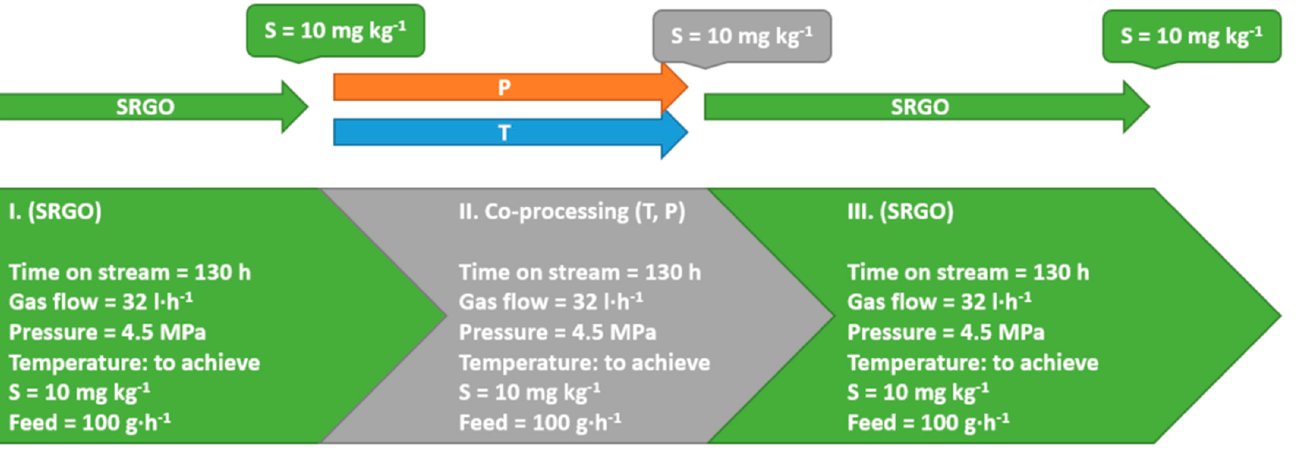
Figure 3. Flow sheet diagram. Table 4. Properties of the testing.